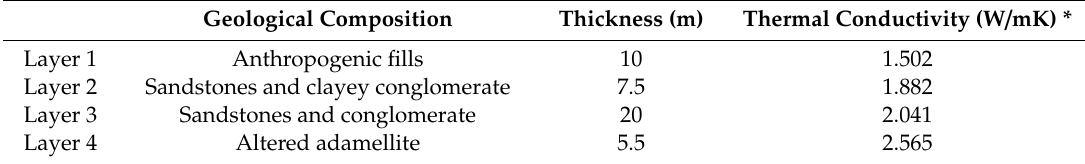
Table 2. Borehole column, geological layers, thicknesses and thermal conductivity